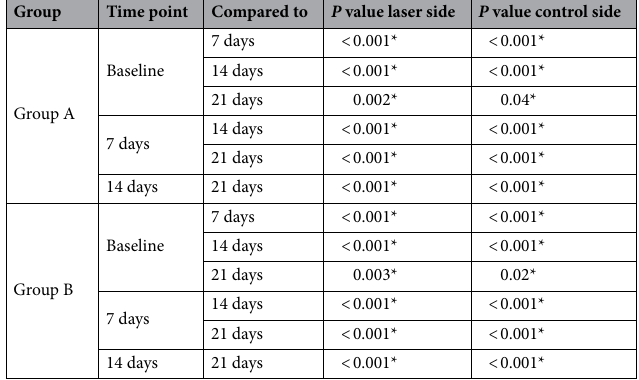
Group Time point Compared to P value laser side P value control